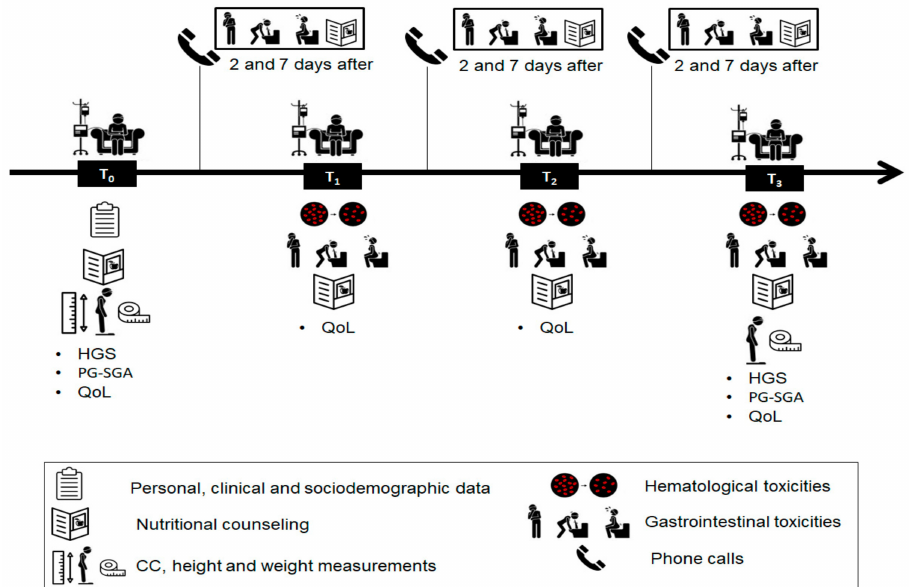
Figure 1. Steps of data collection. Abbreviations: CC, Calf Circumference; HGS, Handgrip strength; QoL, Quality of life; PG-SGA, Patient-Generated Subjective Global